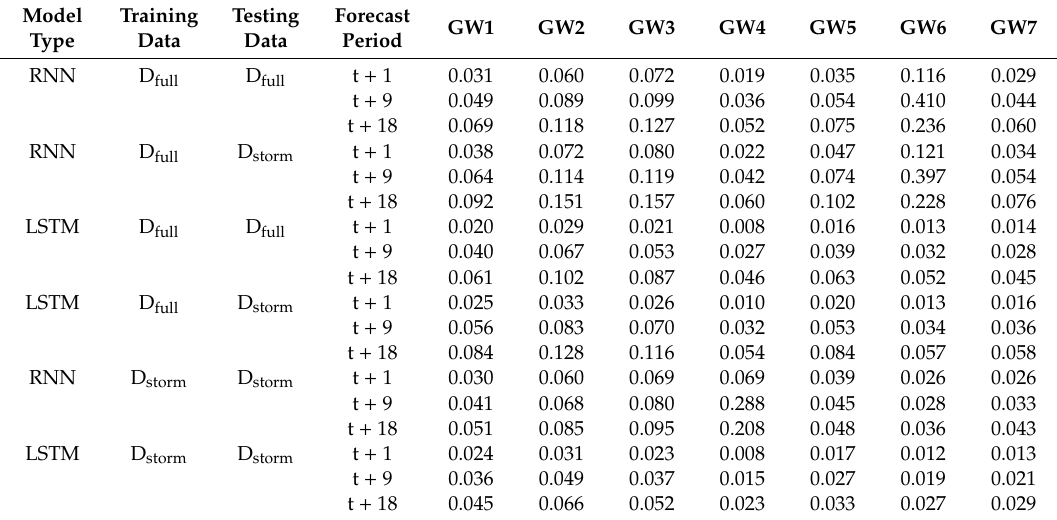
Table A1. Mean mean absolute error (MAE) values for each model type and training dataset treatment at each well and forecast period when tested on observed data.